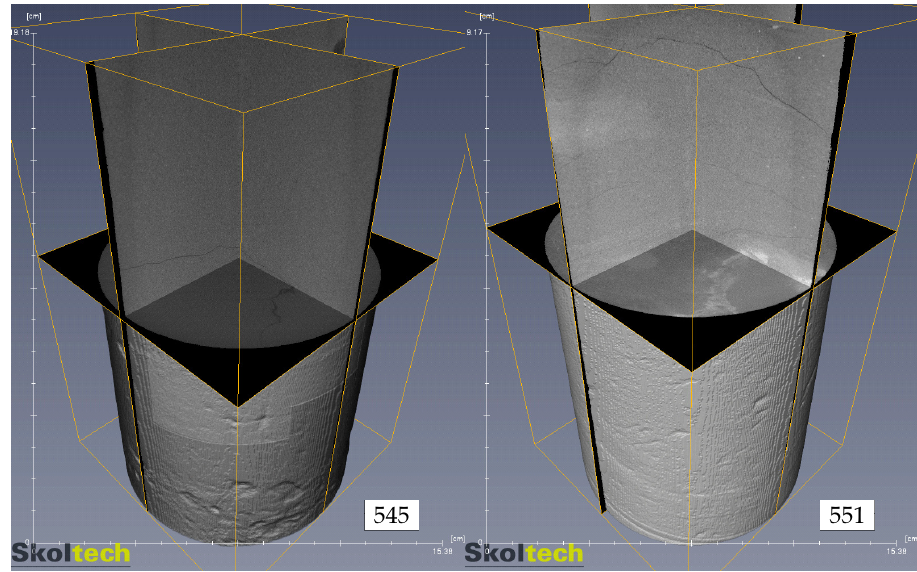
Figure 8. Visualization of 3D X-ray density models resulting from whole-core CT of the target rock samples.